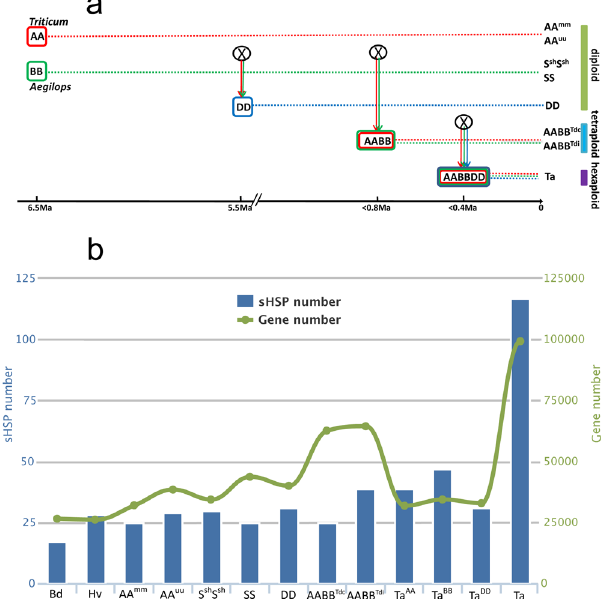
Figure 1. Number of sHSPs in wheat and related species. ( a ) Evolutionary history of bread wheat. The symbol ‘X’ in circle mark hybridisation event. This figure is modified from [Marcussen, T. et al . Ancient hybridizations among the ancestral genomes of bread wheat. Science 345 (2014)] 30 . Reprinted with permission from AAAS. ( b ) Numbers of sHSPs in different species. Left Y axis represents the identified sHSP numbers and right Y axis represents the gene numbers contained in the genome sequences analysed. Abbreviations: Ma, million years ago; Bd, Brachypodium distachyon ; Hv, Hordeum vulgare ; AA mm , Triticum monococcum ; AA uu , Triticum urartu ; S sh S sh , Aegilops sharonensis ; SS, Aegilops speltoides ; DD, Aegilops tauschii ; AABB Tdc , Triticum durum , cv. Strongfield; AABB Tdi , Triticum durum , cv. Cappelli; Ta AA , subgenome A of bread wheat; Ta BB , subgenome B of bread wheat; Ta DD , subgenome D of bread wheat; Ta, Triticum aestivum